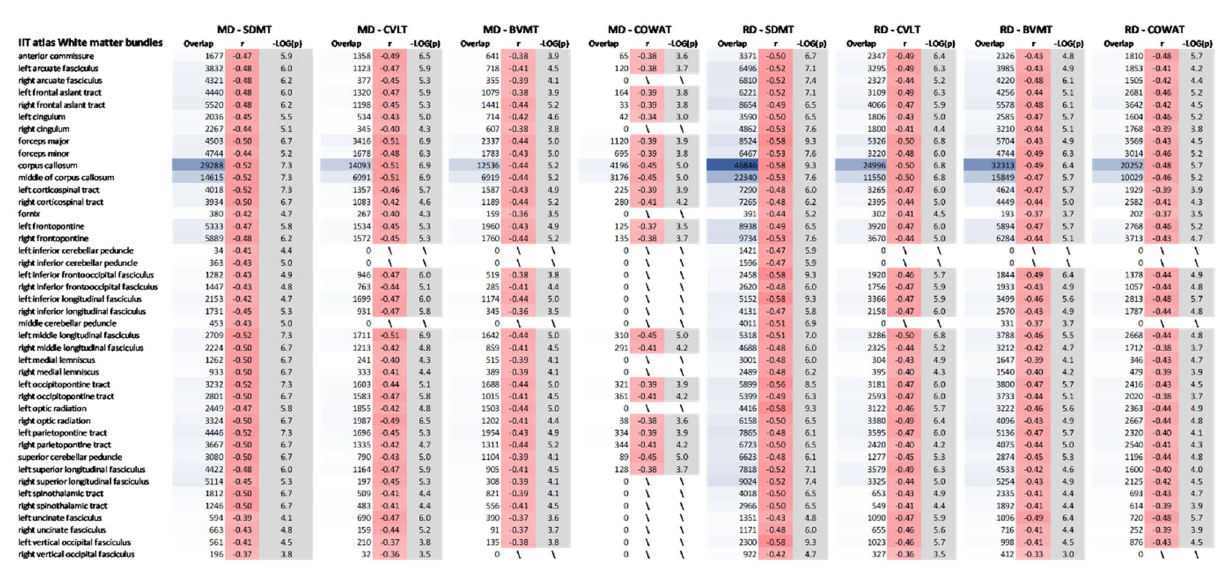
Table 3. Strongest observed correlations between the diffusion tensor parameters and neuropsychological z-scores for each bundle of the IIT white matter bundle atlas. Bundles presenting no significant correlations are indicated with a backslash, and a red (negative) and green (positive) colour palette is used to ease visual interpretation of the r-values strength and direction. The r column represents the strength of the correlation and the − LOG( p ) shows the significance on the inverse logarithmic scale (the cut-off p value of 0.001 is − LOG10( p ) = 3). The volume of the shared region between the considered cluster and the tracks is shown in mm 3 . MD mean diffusivity, RD radial diffusivity, BVMT brief visuospatial memory test-revised,